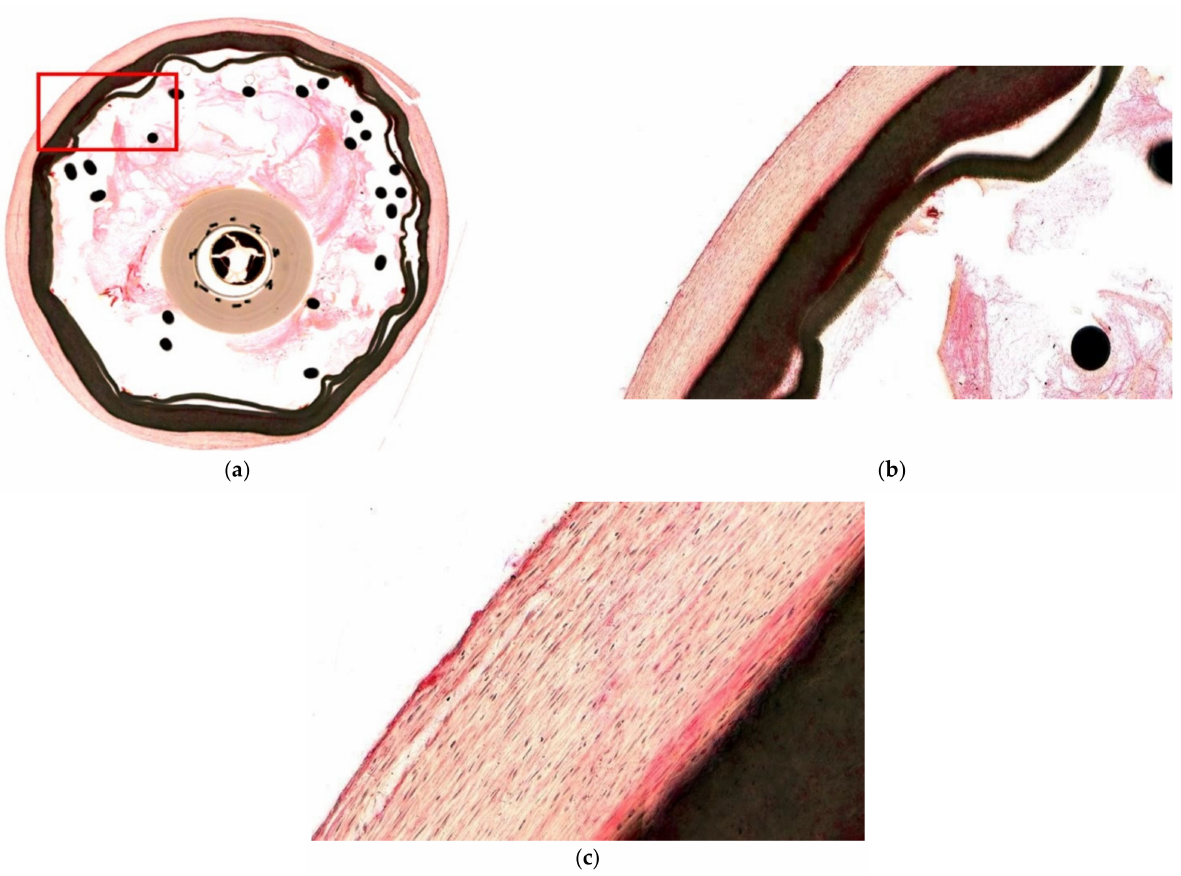
Figure 4. Pathology result of closed type spacer. ( a ) Outside the spacer ePTFE coating, epithelialization harbors coverage discontinuously. The space between the outer and inner membrane is filled with fibrin. ( b ) Some of the cells (RBCs) can be seen to be permeated into the ePTFE, but the endothelial cells are well covered above it, forming a kind of protective film. ( c ) The neointima covers the outer membrane without significant foreign body reaction or inflammation.